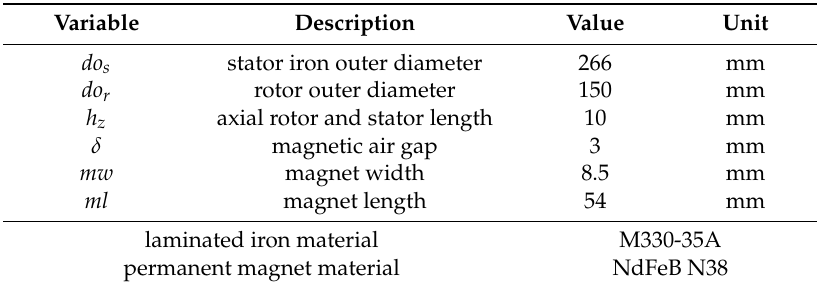
Figure 11. Geometric parameters of the bearingless flux-switching motor. Table 2. Main geometric parameters of the prototype drive.